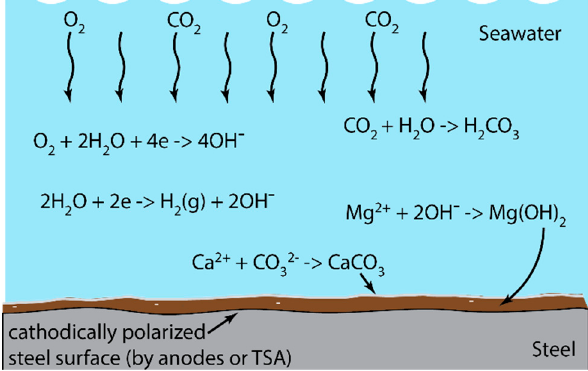
Figure 15. Schematic showing the mechanism of calcareous deposit formation on steel surface.